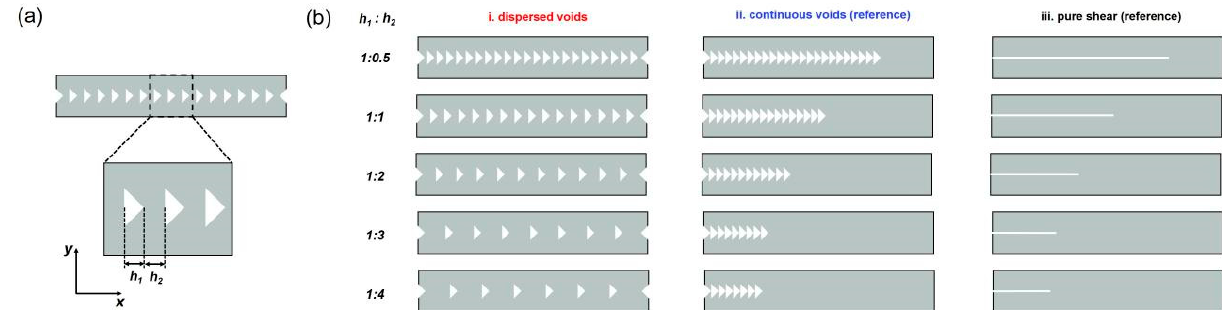
Figure 1. Scheme of the structural models with dispersed cuts and continuous cuts patterns for fracture experiments. ( a ) Scheme of the structural model containing an array of dispersed cuts investigated in this work. The length scale h 1 is defined as the horizontal size of the triangle-shaped cuts, while h 2 represents the horizontal spacing between adjacent cuts. In this work, the h 1 is kept constant at 1.5 mm for simplicity. ( b ) The structural models with dispersed cuts at different spacing ratios h 1 : h 2 (1:0.5, 1:1, 1:2, 1:3, and 1:4) and their counterpart structural models with the same number of aligned continuous cuts. The pure shear model was used as the